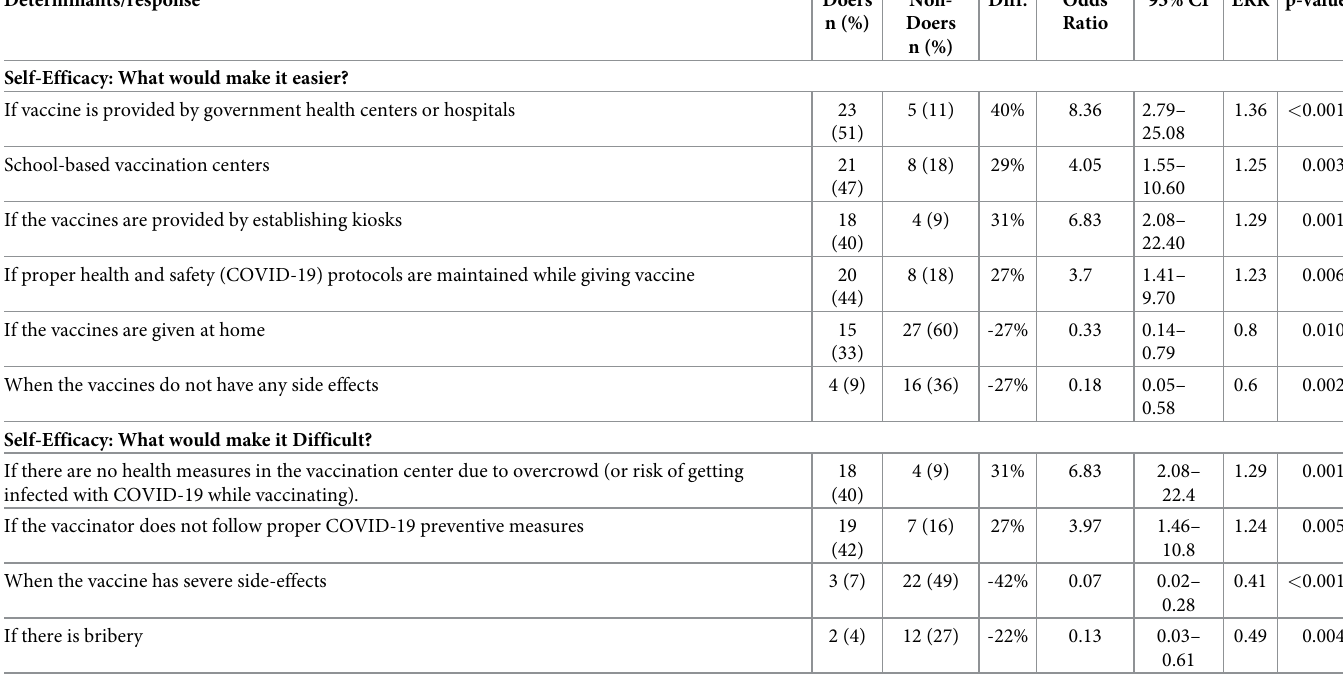
Table 4. Perceived